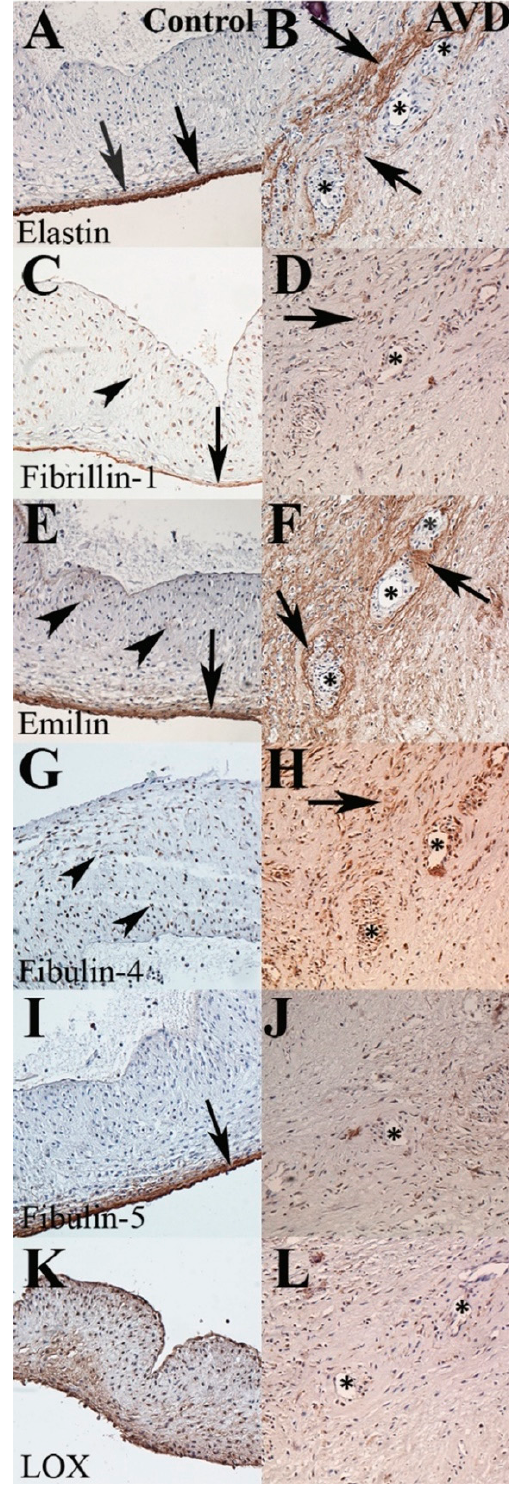
Figure 2. Specific elastic fiber components are associated with overt angiogenesis. Representative sections from control (left column, A , C , E , G , I , K ) and early-onset AVD (right column, B , D , F , H , J , L ) specimens. In control tissue, elastin and fibulin-5 are localized in the cusp ventricularis layer (arrows), but fibrillin, emilin, fibulin-4, and LOX are also expressed weakly in all layers (arrowheads). In AVD tissue, elastin, fibrillin, emilin, and fibulin-4 are associated with neovessels (asterisk, B , D , F , H ), whereas fibulin-5 and LOX are not ( J , L ).